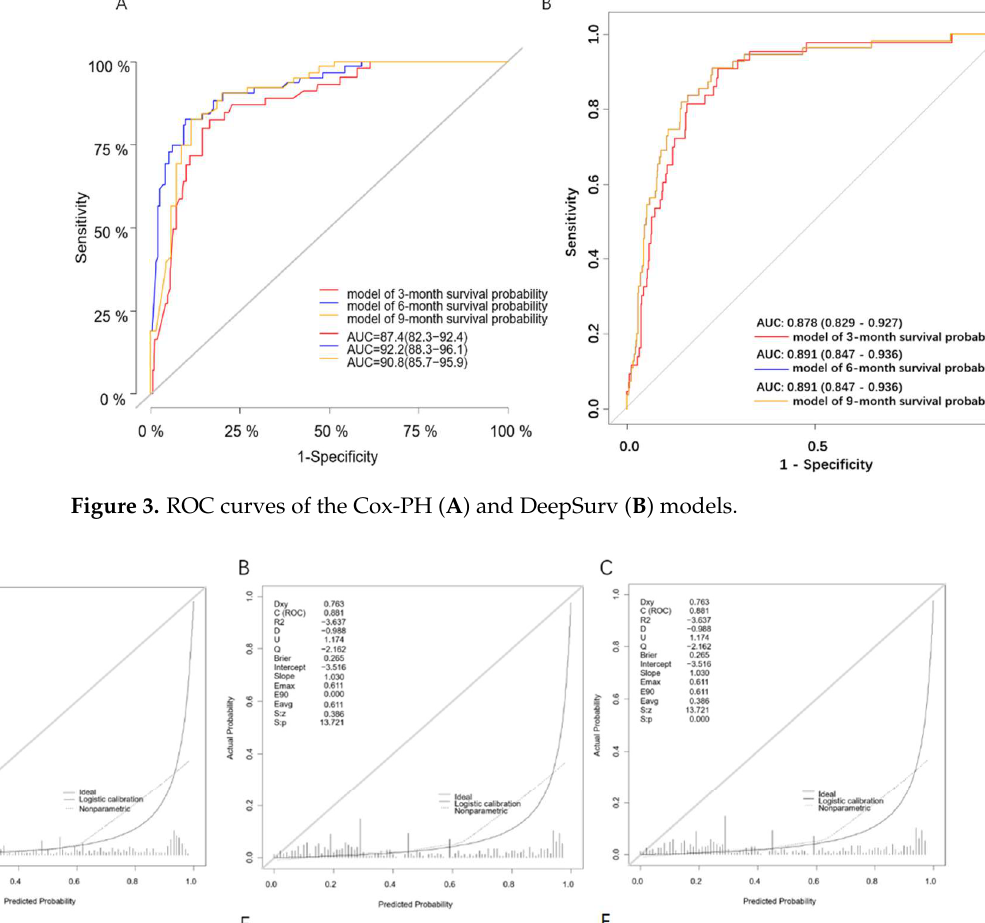
Figure 5. Decision-curve analysis of the Cox-PH ( A – C ) and DeepSurv ( D – F ) models for 3-, 6- and 9- month cancer-specific survival.